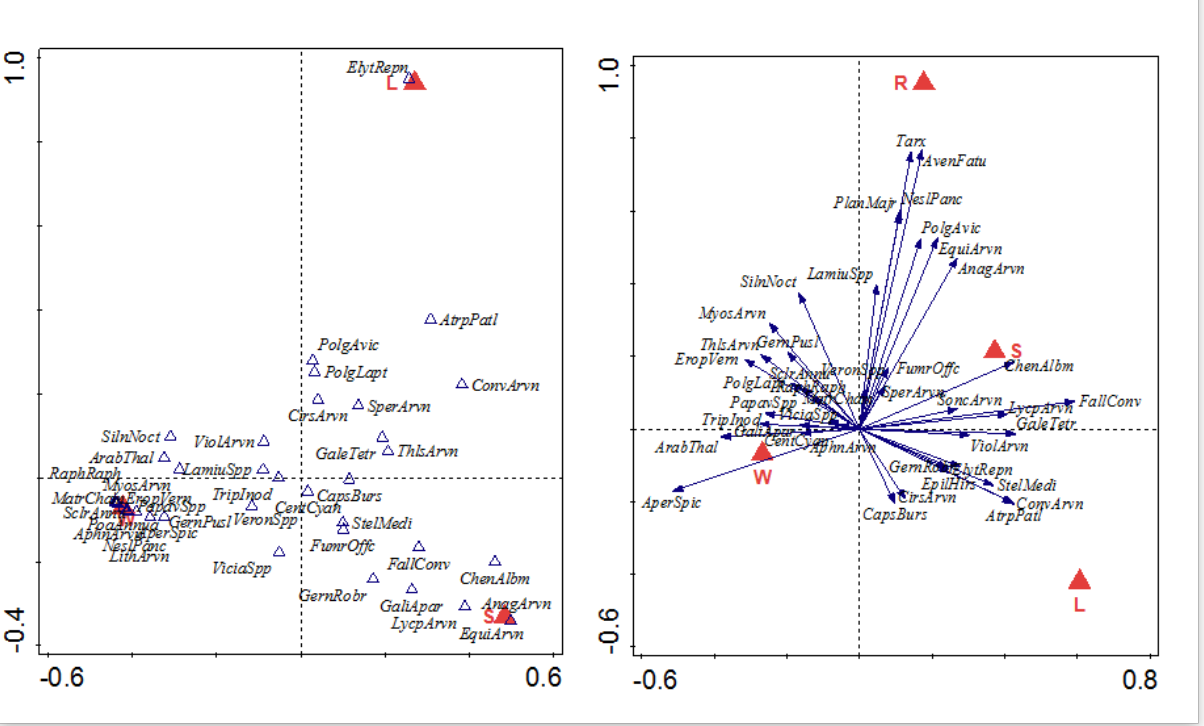
Figure 5. Influence of crop type on weed species composition at untreated Pernolec plots in simple crop rotation ( left ) and multi-crop rotation ( right ). Crop type is the explanatory variable and year is the covariate; species with low weight are not shown. W-winter cereals, S-spring cereals, L-legumes, R-root crops.